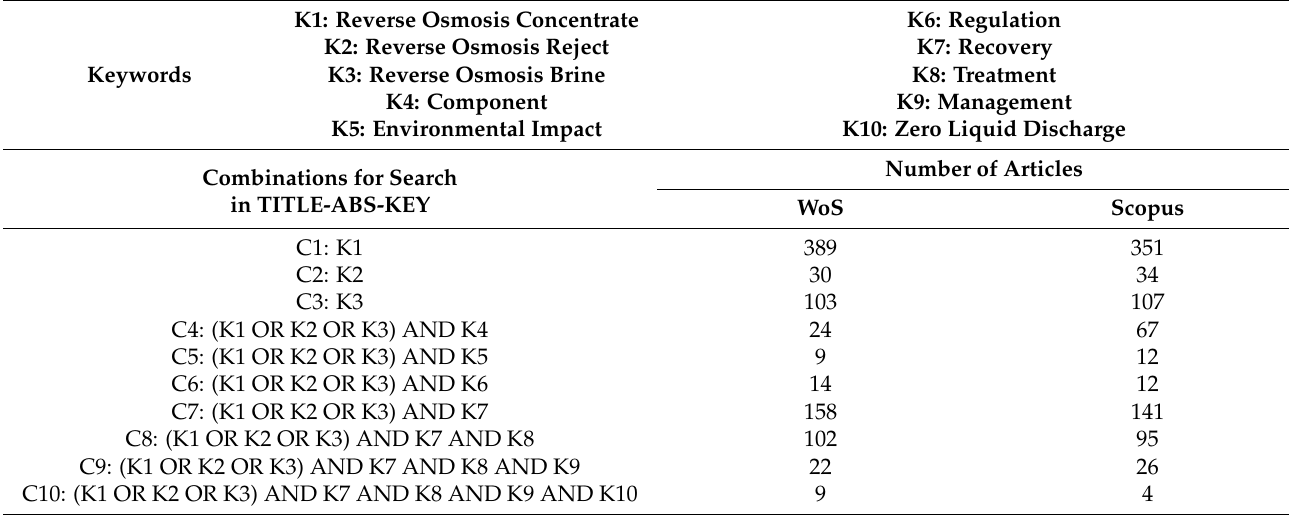
Table 1. Keyword combinations to search for information about